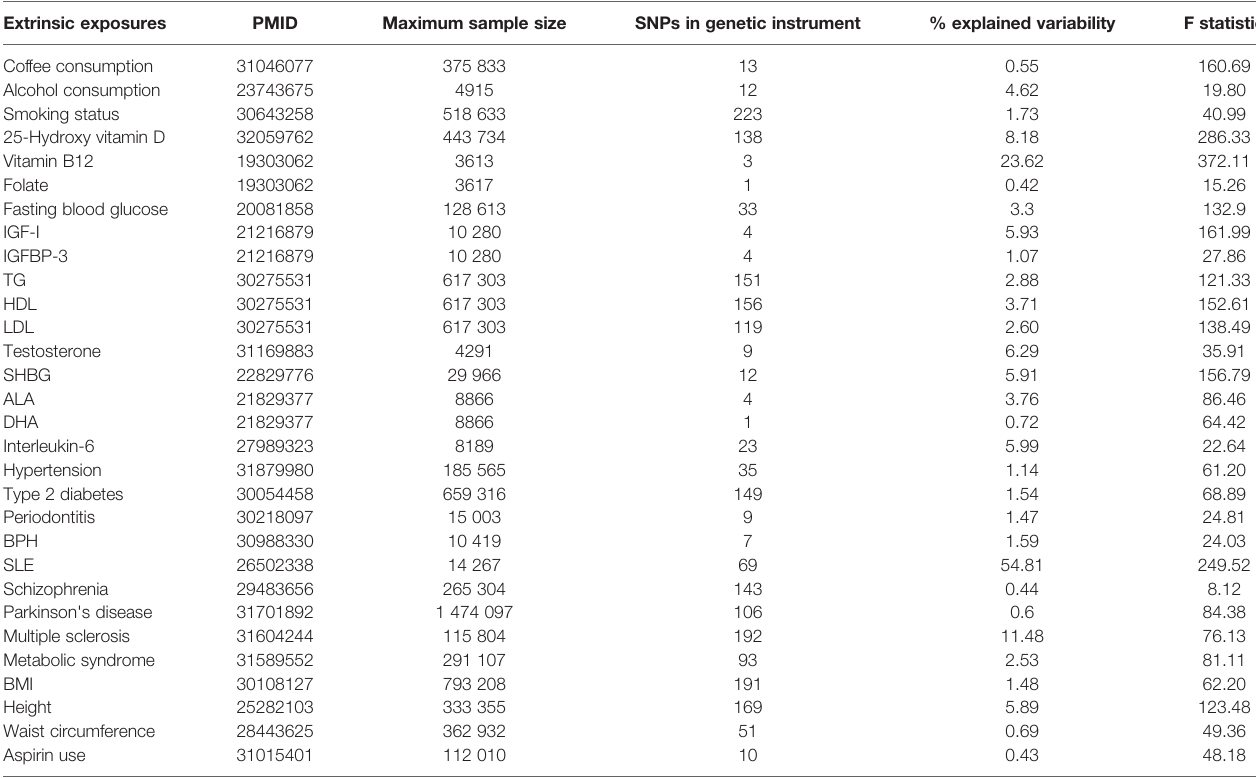
TABLE 1 | Summary of genetic instruments used in the present Mendelian randomization analysis. Extrinsic exposures